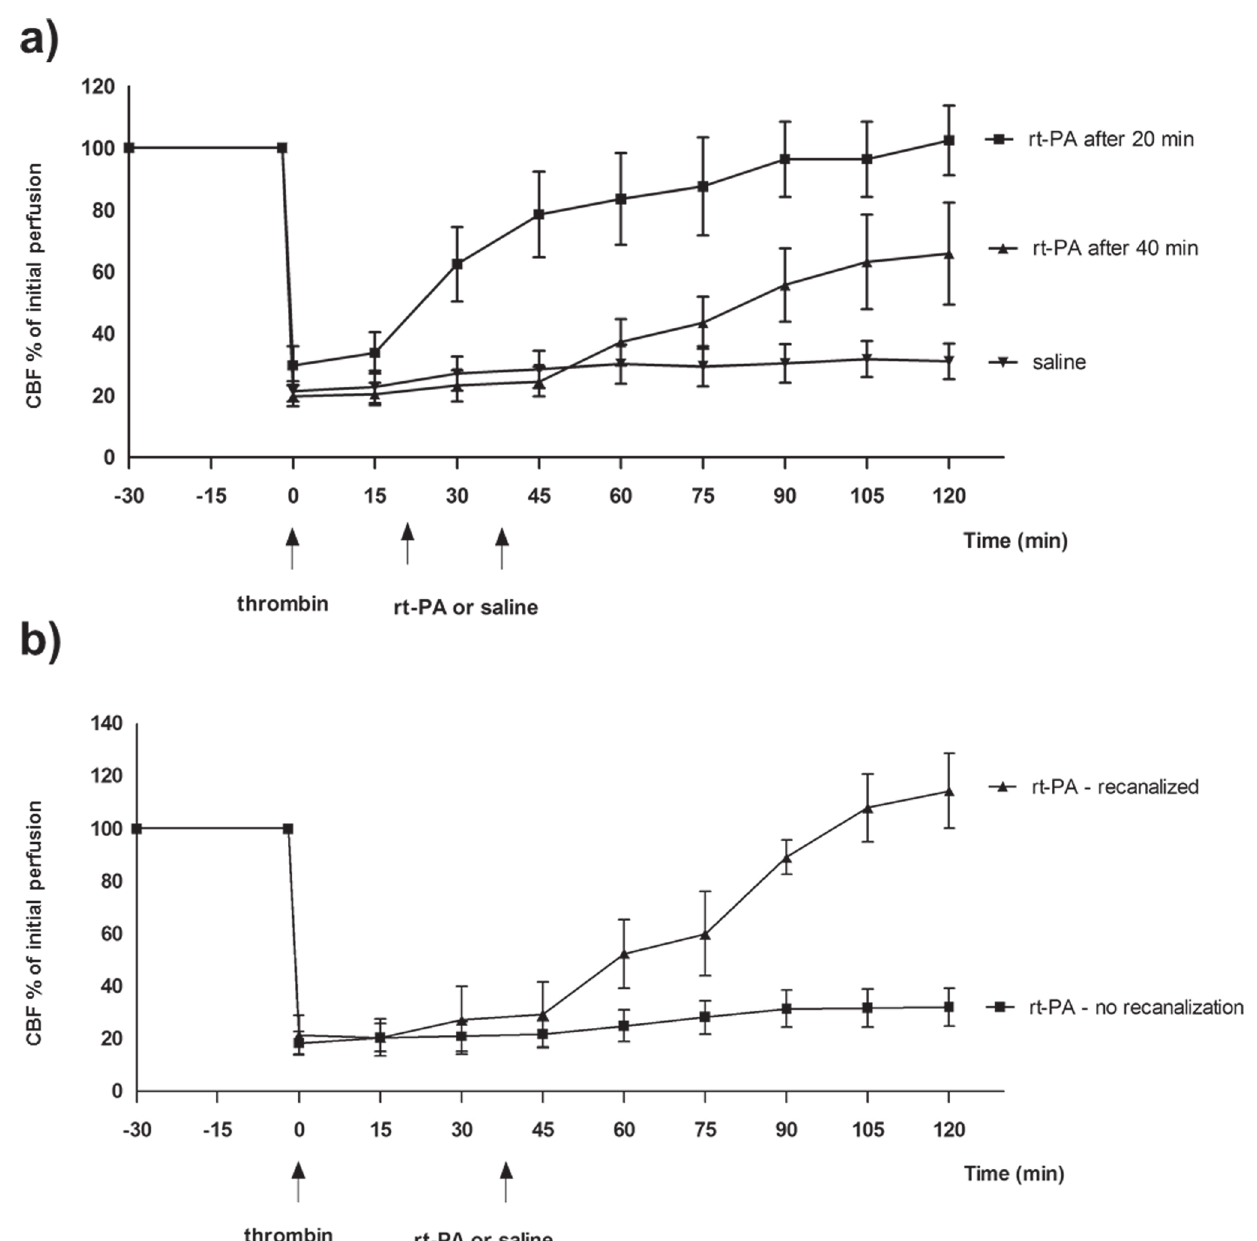
Figure 2. Effect of treatment with rt-PA on CBF after MCAO in mice. (a), MCAO + rt-PA after 20 min and 40 min, (b), MCAO + rt-PA after 40 min. Data were obtained by laser Doppler flowmetry and are expressed as mean 6 s.e.m. values, n=5–9 *P # 0.05, **P # 0.01, ***P , 0.001 significant difference between treated groups and MCAO groups. Statistical analyses were performed using Kruskal-Wallis non-parametric test together with Dunn’s post-hoc